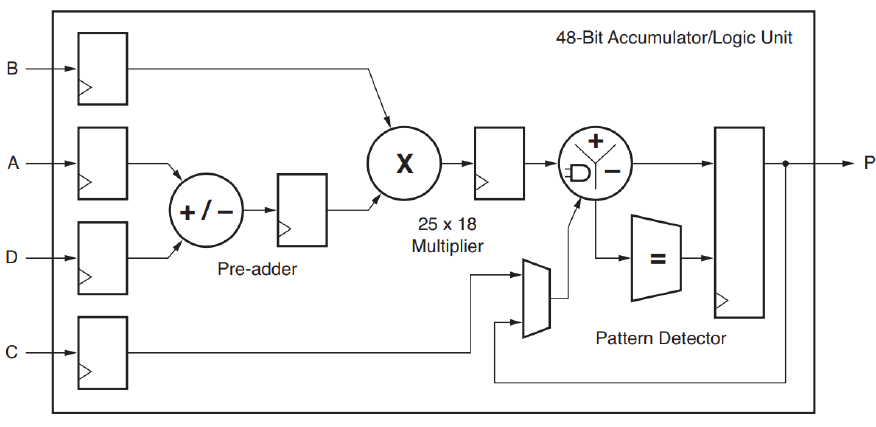
Figure 11. Basic structure of DSP48E1 Slice [10].